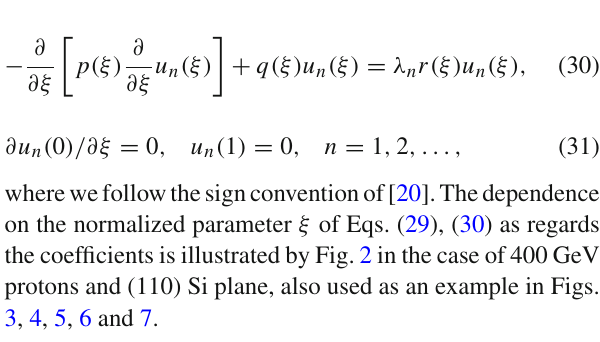
Fig. 6 Crystal depth dependence of the channeling probability (33) ( solid line, top ) and dechanneling rate ( solid line, bottom ) and their fits by the function (37) and its reversed-sign derivative, respectively ( crosses ) The eigen values λ n are positive and monotonically increase with their number n , equal to that of the corresponding eigen state u n (ξ) nodes minus one. The completeness property of the system of eigen states of the problem (30), (31) allows one to represent any solution of Eq. (29) in the form of an